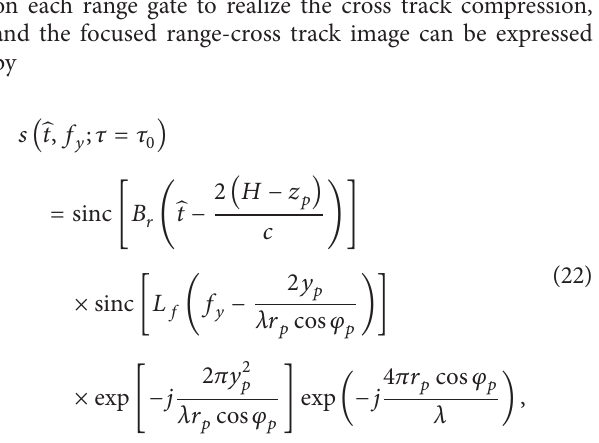
Then a cross track direction Fourier transform is performed on each range gate to realize the cross track compression, and the focused range-cross track image can be expressed by